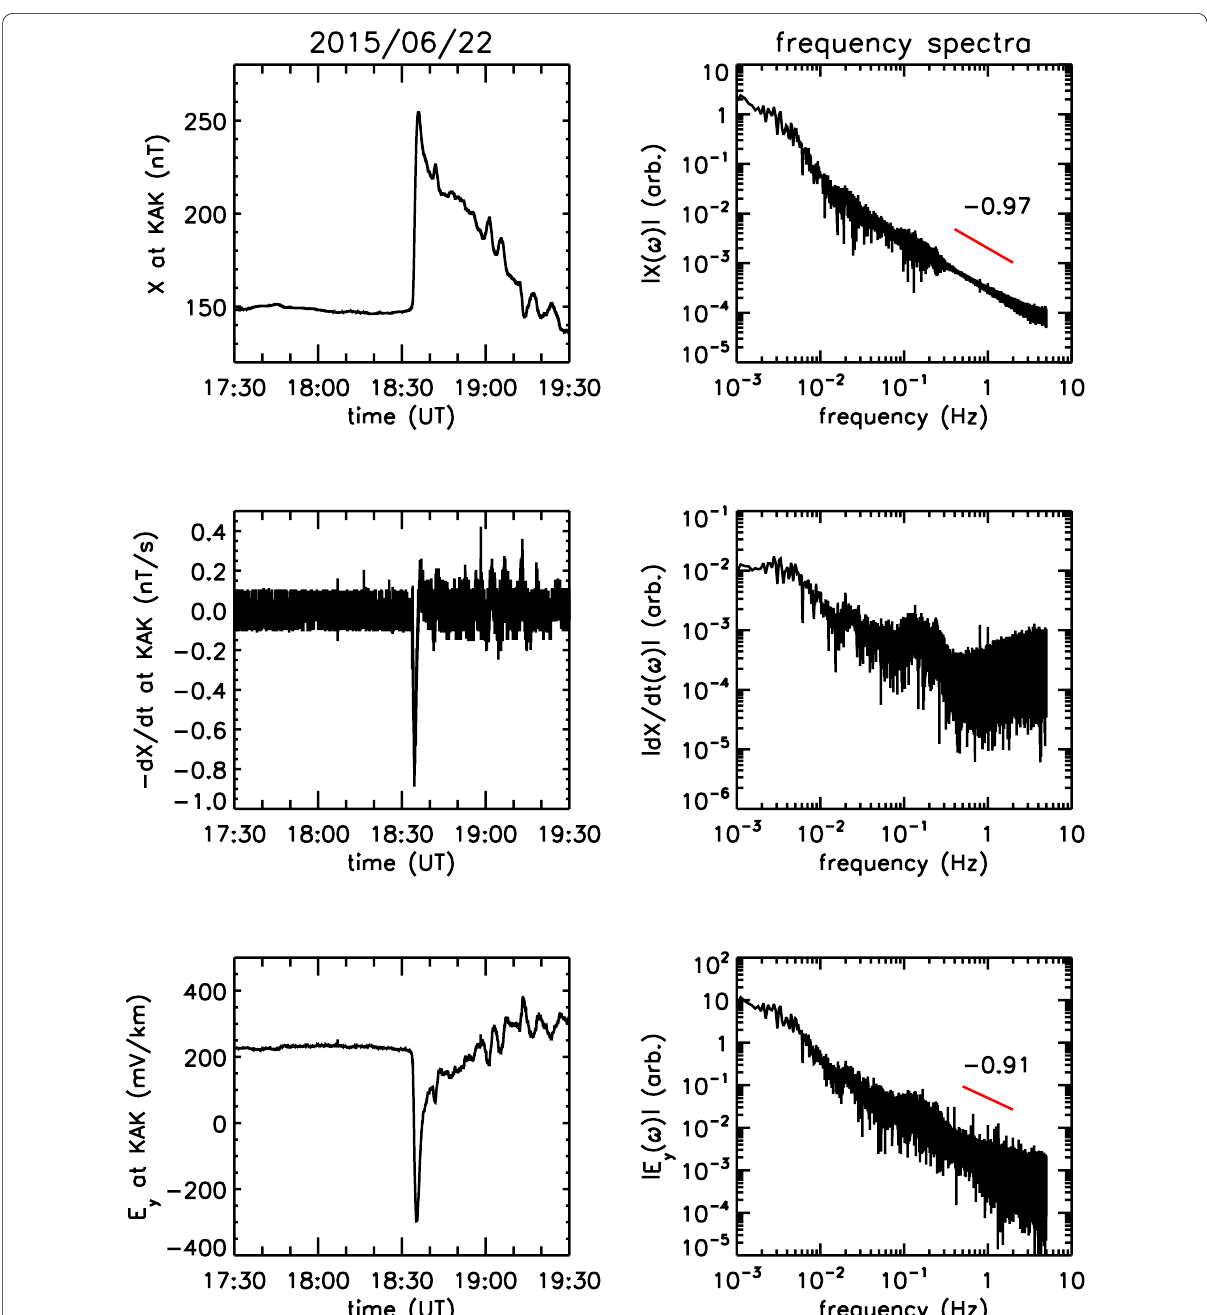
Fig. 1 0.1-s data of X-component geomagnetic field at KAK (top-left panel), negative values of its time derivative (middle-left panel), and Y-component geoelectric field at KAK (bottom-left panel) of the 22 June 2015 SSC and their frequency spectra (right